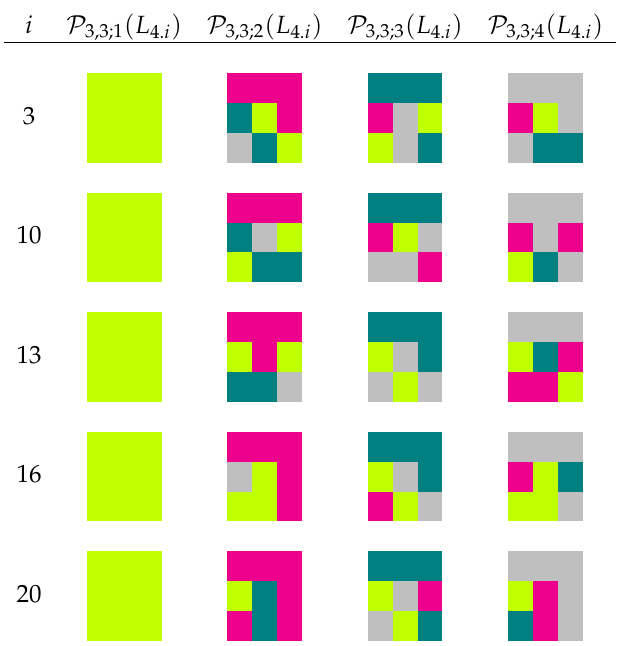
Figure 3. Standard 3 × 3 image patterns associated to L 4.3 , L 4.10 , L 4.13 , L 4.16 and L 4.20